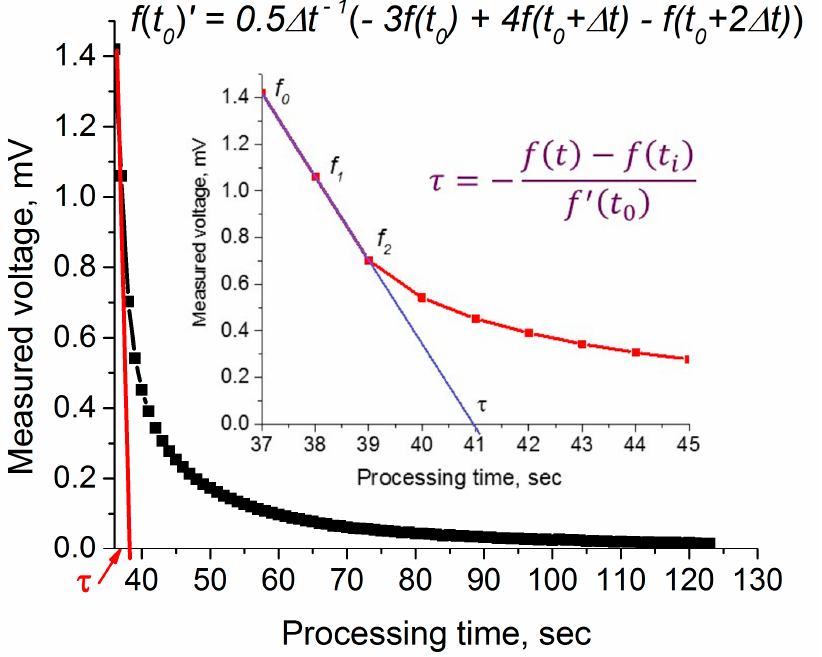
Figure 8. Derivation of the relaxation time from hot-probe measurement; inset shows the characteristic processing.